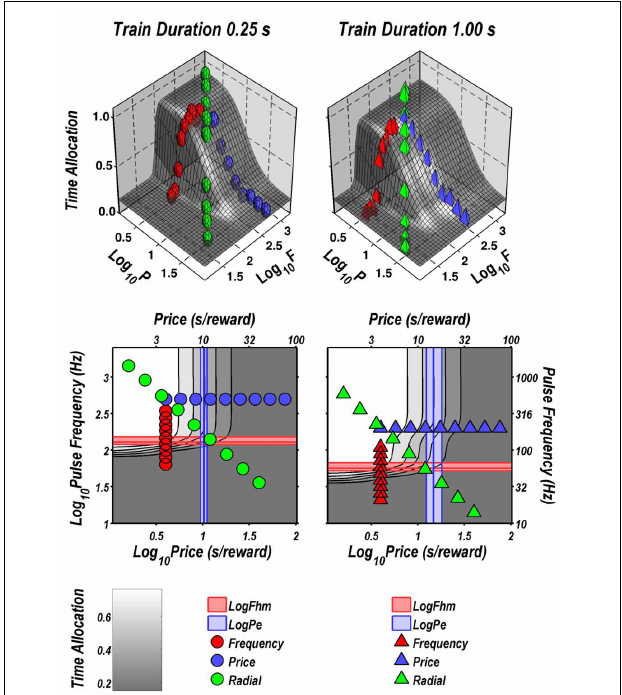
FIGURE 13 | Fit of the dual-integrator model to the data from rat C17. Top row : 3D surfaces showing how time allocation varies as a function of pulse frequency and price. Individual data means along the pulse-frequency (red), price (blue), and radial (green) sweeps are designated by polyhedrons (0.25s trains) or pyramids (1s trains). Note the indentation in the surface fit to the data obtained at the longer train duration (upper right). This indentation is due to the offset between the pulse frequencies over which reward intensity grows in the two integrators (upper and lower 3D graphs in Figure 12 ). Bottom row: contour graphs corresponding to the surfaces in the row above. The vertical blue line represents the estimate of P e , and the surrounding band represents the corresponding 95% confidence interval. The horizontal red line represents the estimate of F hm , and the surrounding band represents the corresponding 95% confidence interval. The wiggles in the contour lines in the graph for the longer train duration (lower right) correspond to the indentation in the surface shown above.